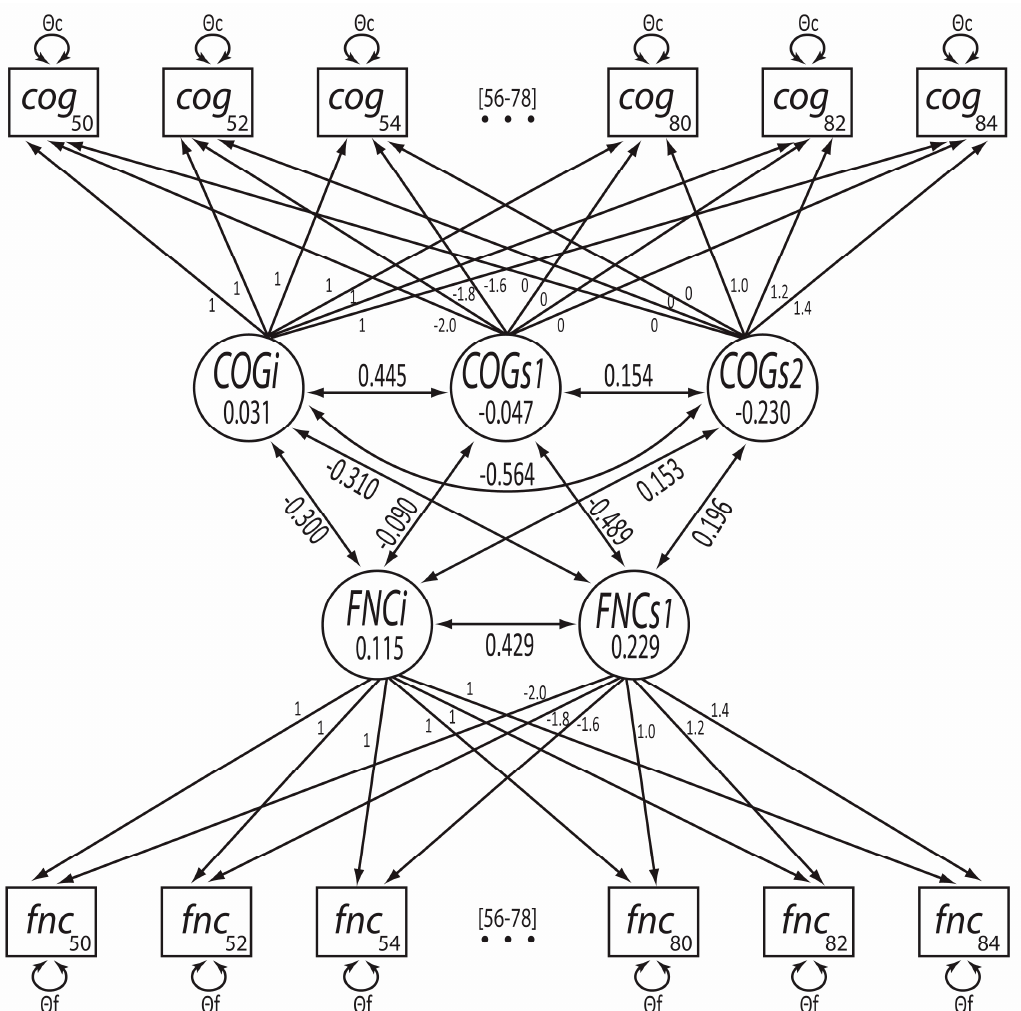
Figure 2. Path diagram of the best-fitting bivariate trajectory model. COG = Cognition Factor. FNC = Functional Limitation Factor. Subscripts for these factors (i, s1, s2) correspond to latent intercepts and slopes. Numerical values shown beneath factor labels are the estimated means. Numerical values on pathways connecting the factors (double-headed arrows) are correlations. Change in cognitive ability was modeled using a linear spline parameterization with two slopes pre- and post-knot-point at age 70 years. Change in functional limitation was modeled as a single linear slope (bivariate models with splines for functional limitations did not converge). Slopes’ loadings for both processes were scaled in decades, centered at age 70 years. Not shown due to space considerations: paths linked to observations at ages 56–78 years (as indicated by the placeholder ellipses, . . . ), within-timepoint covariances between observed cognitive ability and functional limitation scores, and latent mean